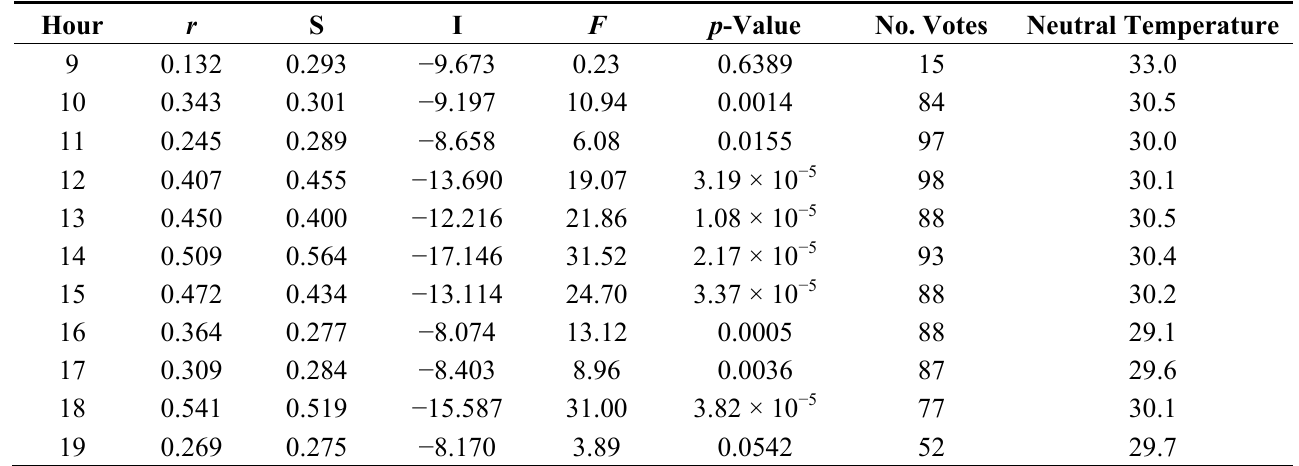
Table 3. Determination of hourly neutral temperatures.